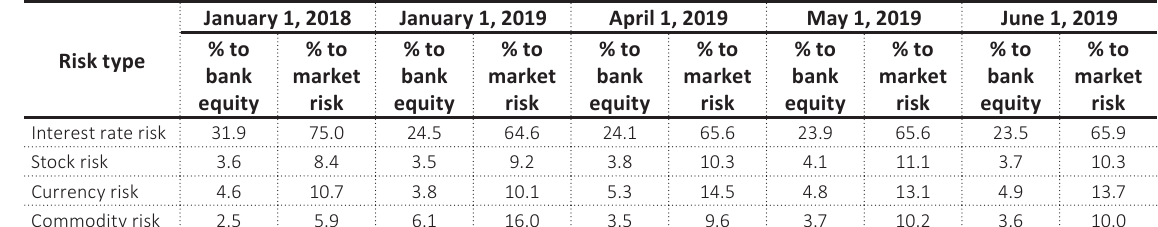
Table 2. Market risk structure of the banking sector, %